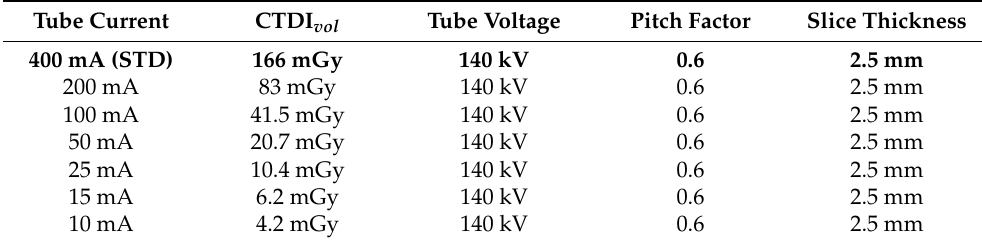
Table 1. Scanning parameters used for phantom measurements. The standard protocol (STD) is highlighted in